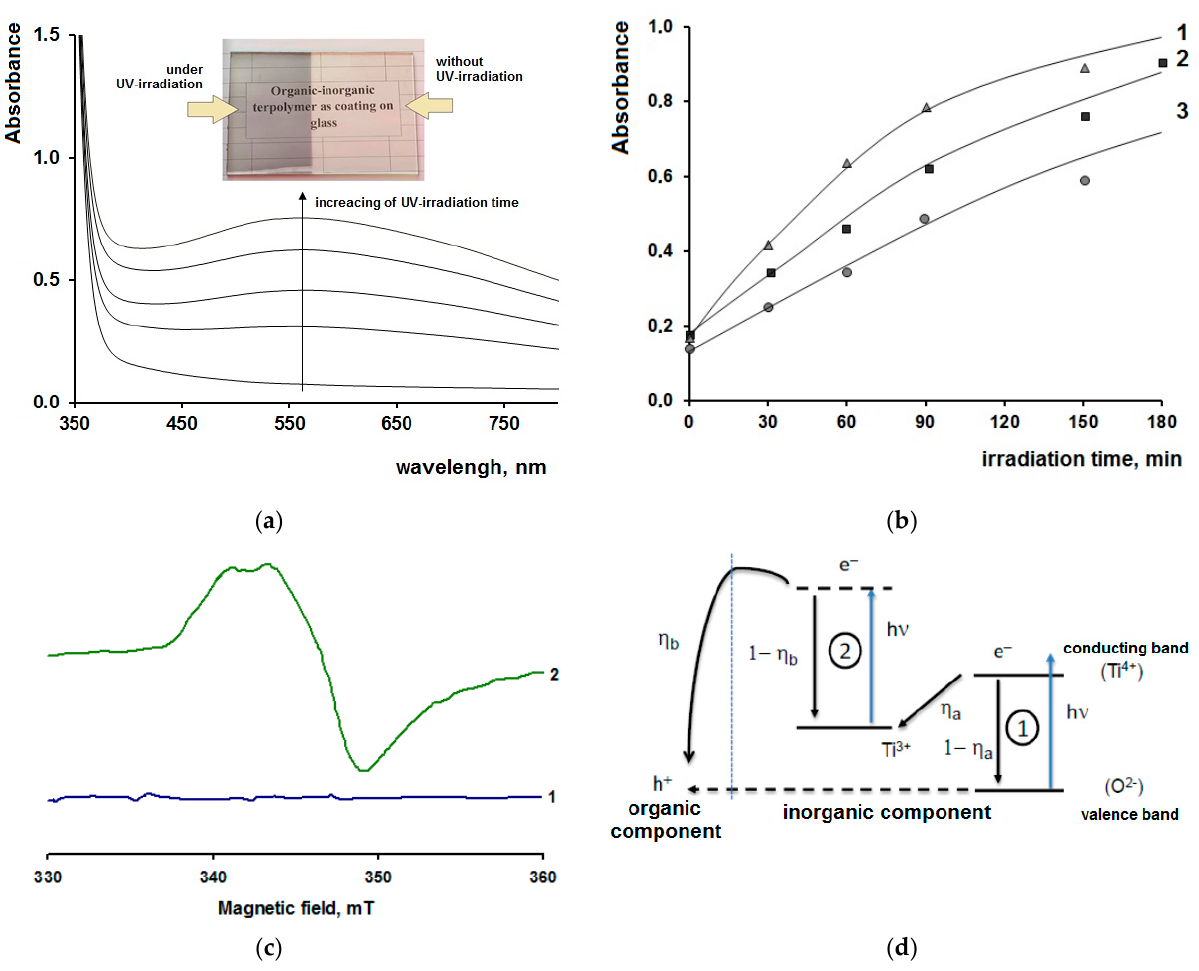
Figure 3. Optical properties of materials of different compositions: ( a ) typical change in the spectra of copolymers upon UV irradiation; ( b ) dependence of the optical density of composites [( ≡ TiO) n ]:[HEMA]:[M] at 600 nm on the time of UV irradiation: curve 1—M = HEMA, curve 2—M = BMA, curve 3—M = AN; ( c ) EPR spectra of material with composition [( ≡ TiO) n ]:[HEMA]:[M] = 1:5:1: curve 1—without UV irradiation, curve 2—UV irradiated sample; ( d ) scheme of possible processes occurring in PTO gels in alcoholic media or in organic–inorganic copolymers under UV irradiation.